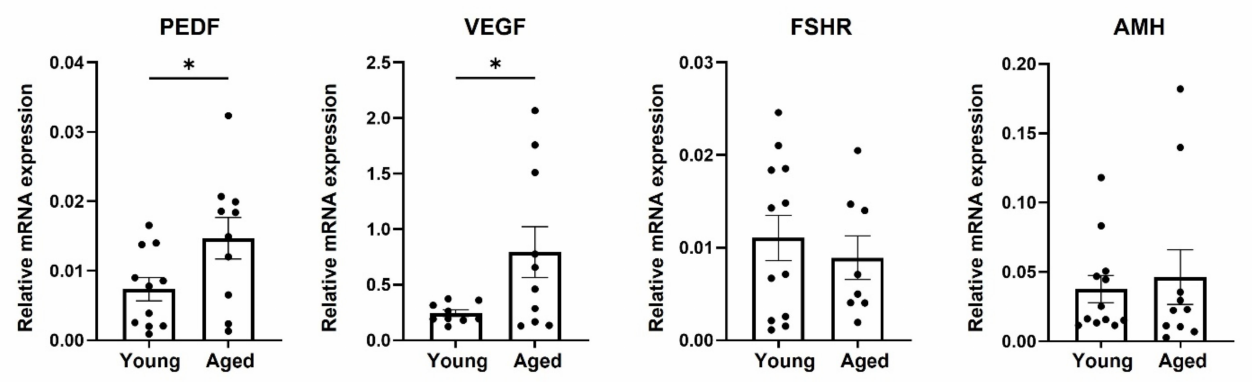
Figure 2. mRNA expression of selected genes in hpGCs. Human primary granulosa cells were isolated from follicular fluids of two groups of IVF patients: (1) young patients (“Young”; 20–35 y) and (2) RA patients (“Aged”; 36–44 y), triggered with hCG. Cells were pooled, incubated for 24 h, and then collected and subjected to qPCR analysis of PEDF, VEGF, FSHR, and AMH expression. Number of pools in each experimental group: n > 10 (two-to-three women per pool; each black circle represents one pool). Genes were calibrated with HPRT-1. Data are presented as mean ± SEM. Results were analyzed by Student’s t -test with Welch’s correction, * pv <